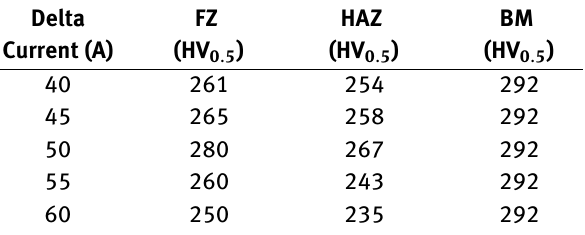
Table 8: Effect of Delta Current on microhardness of various regions Delta